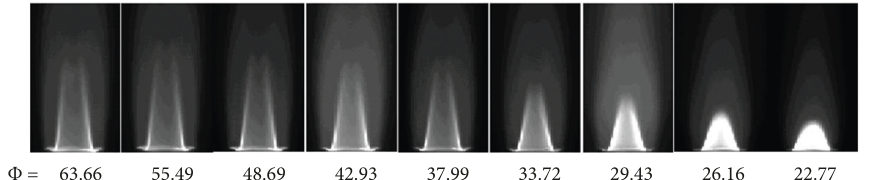
Figure 4: Images of the Saudi LPG/air flames for different equivalence ratios with mixing before the orifice port using the traditional Bunsen burner.